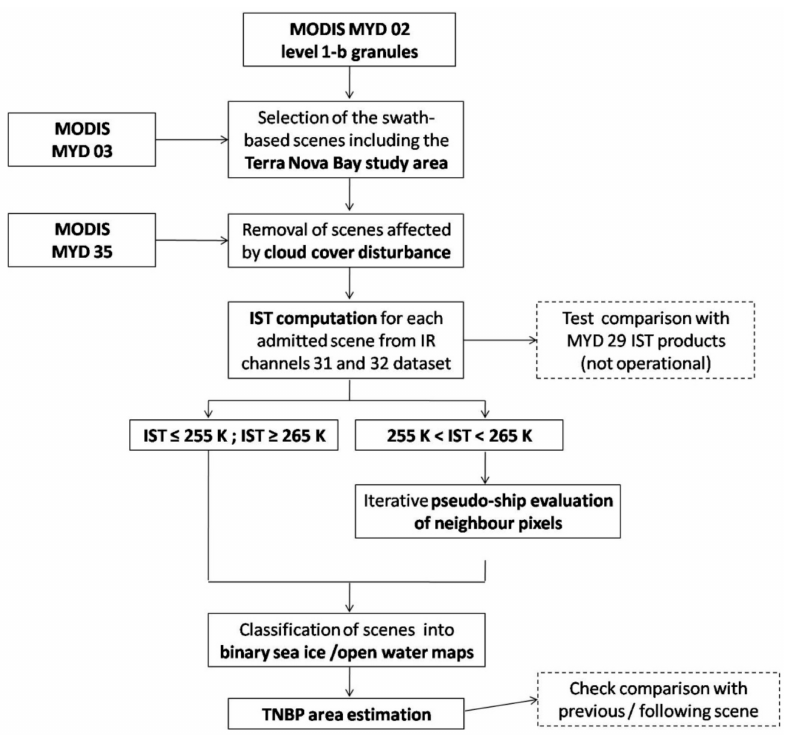
Figure 2. Flow chart of the Terra Nova Bay polynya extent estimation